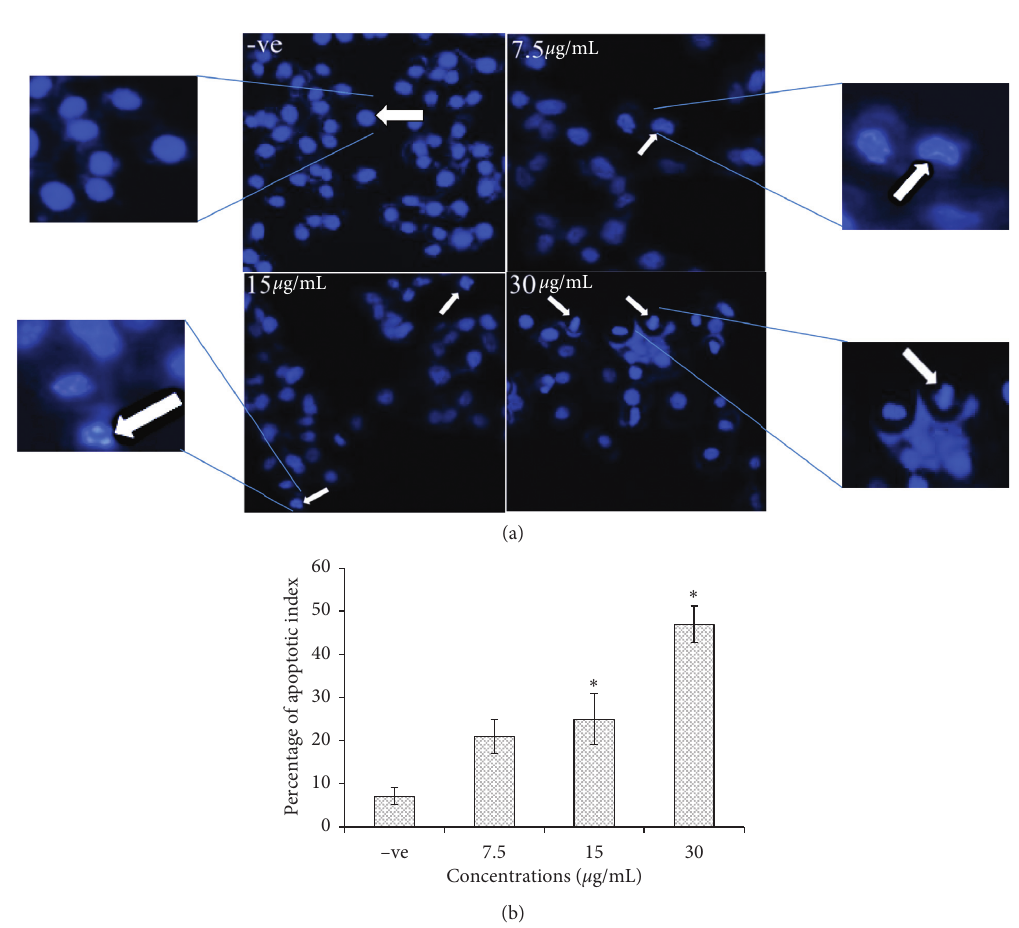
Figure 1: (a) MCF-7 cells in Hoechst stain demonstrate the normal morphology in the negative control ( − ve) and the morphological changes in treated cells at different concentrations of EHX: kidney shape, apoptotic body, and cell shrinkage. Magnification is 20x. (b) Percentage of the apoptotic index at concentrations of 7.5, 15, and 30 μ g/mL. Values are mean ± SD. ∗ p < 0.05.